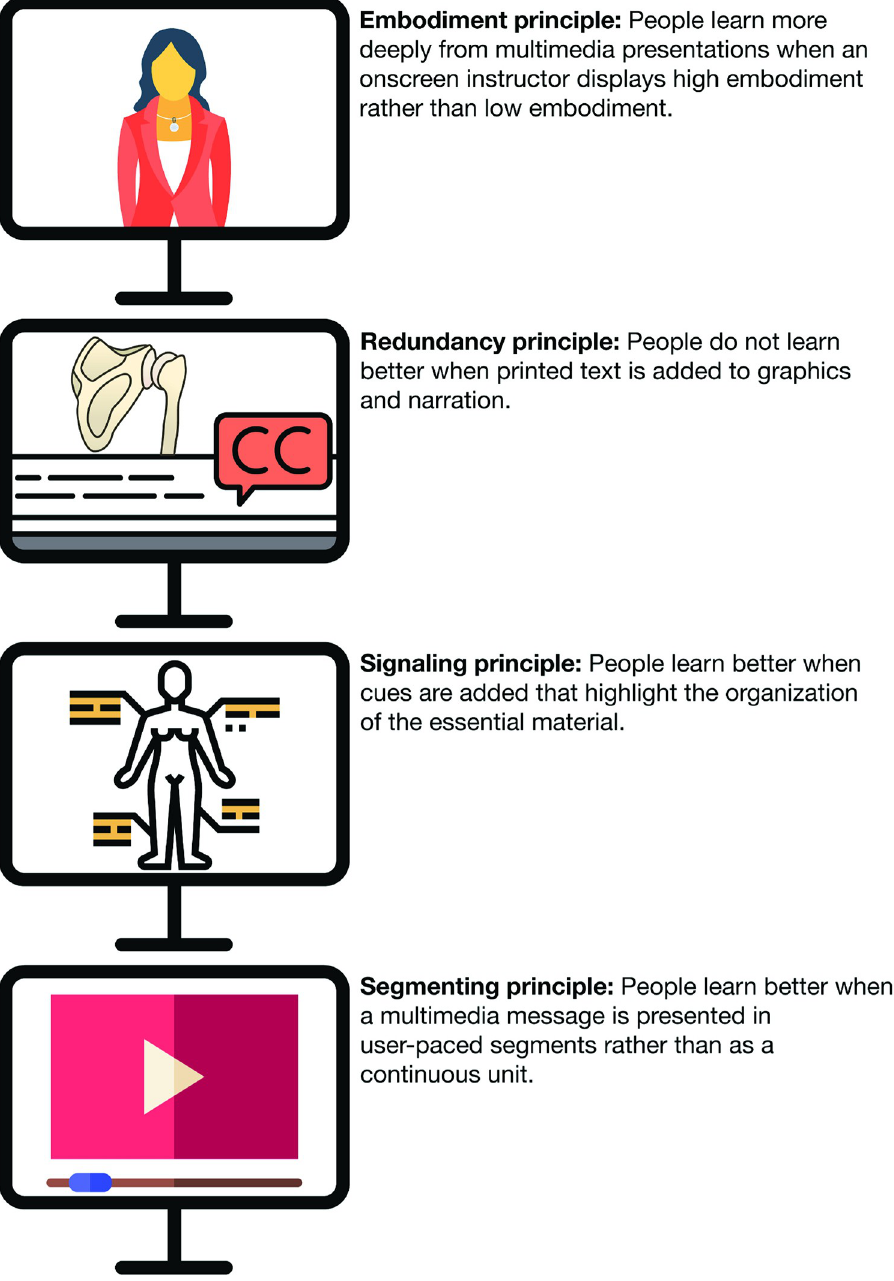
Fig 1. Demonstration and explanation of the image/embodiment, redundancy, signalling and segmentation principles.